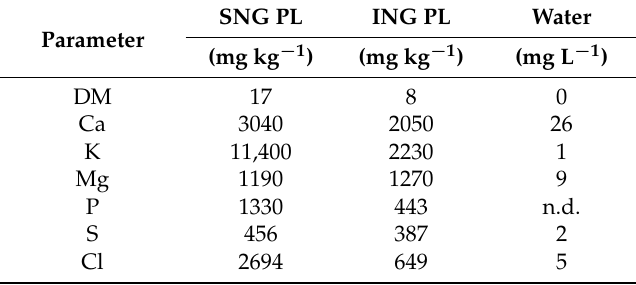
Table 3. Experiment 3: Mineral concentrations in press liquids (PL), obtained from dewatering biomass from semi-natural (SNG) and intensive (ING) grasslands, and tap